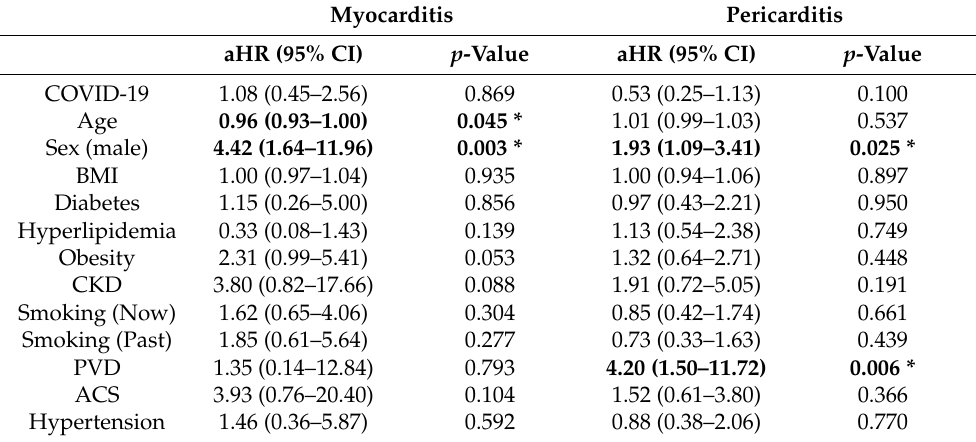
Table 3. Adjusted HRs for myocarditis and